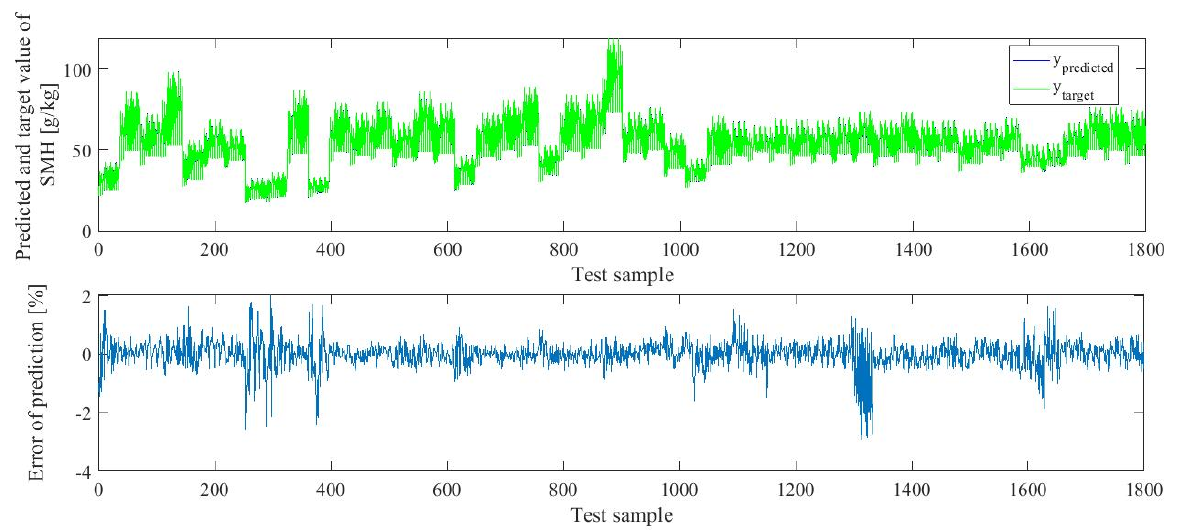
sm for several cases. hydrogen